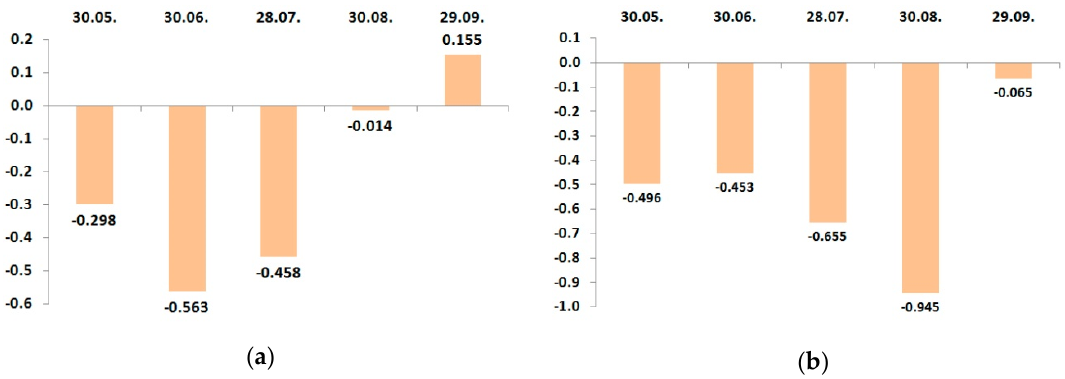
Figure 5. Dynamic changes of correlation coefficients between the leaf calcium status and potassium fertigation rates during the growing season of 2016: ( a ) cv. “Zhigulevskoye”; ( b ) cv. “Lobo”.